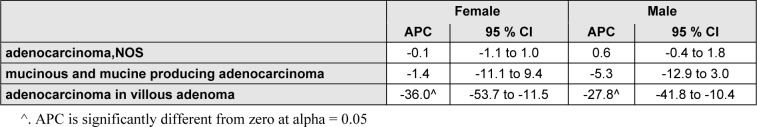
Joinpoint analyses of cancers percentage allocated to the morphology data for colorectal cancer in Iran, 2003-2008